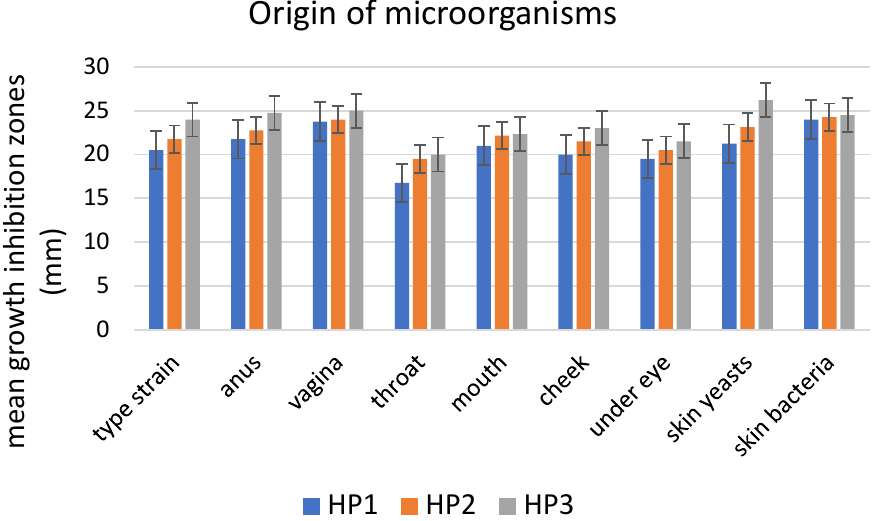
Figure 6. Mean growth inhibition zones (mm) caused by films containing three concentrations of propolis against microorganisms ( Candida spp., n = 18 and commensal skin bacteria, n = 8) depending on the region of the human body the microbial isolates were obtained from. Error bars represent standard deviations.